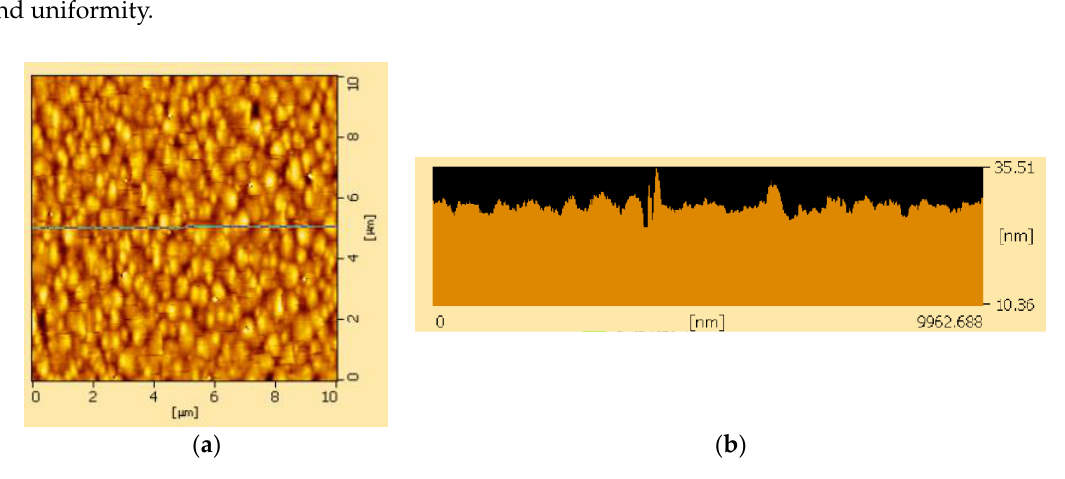
Figure 6. Epitaxy structure diagram of 4 different samples: ( a ) is for Sample #1, ( b ) is for Sample #2, ( c ) is for Sample #3, and ( d ) is for Sample #4.